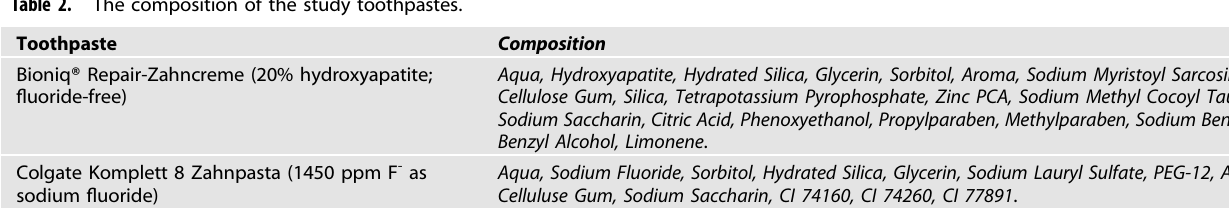
Table 2. The composition of the study toothpastes. Toothpaste